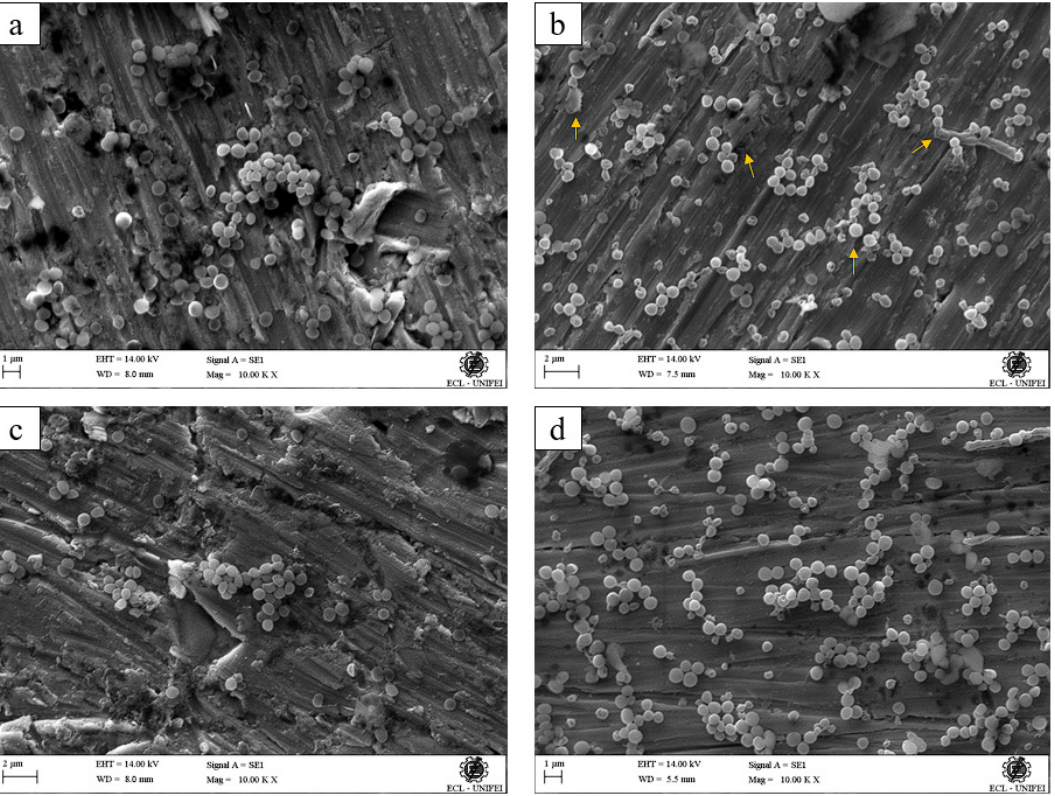
Figure 14. Biofilm distribution on the non-coated and coated Ti-30Ta. ( a ) S. aureus biofilm on Ti- 30Ta polished surface. ( b ) S. aureus biofilm on Ti-30Ta coated with the piezoelectric film. The beads on the surface, represented by the yellow arrow, may influence the biofilm formation. ( c ) S.